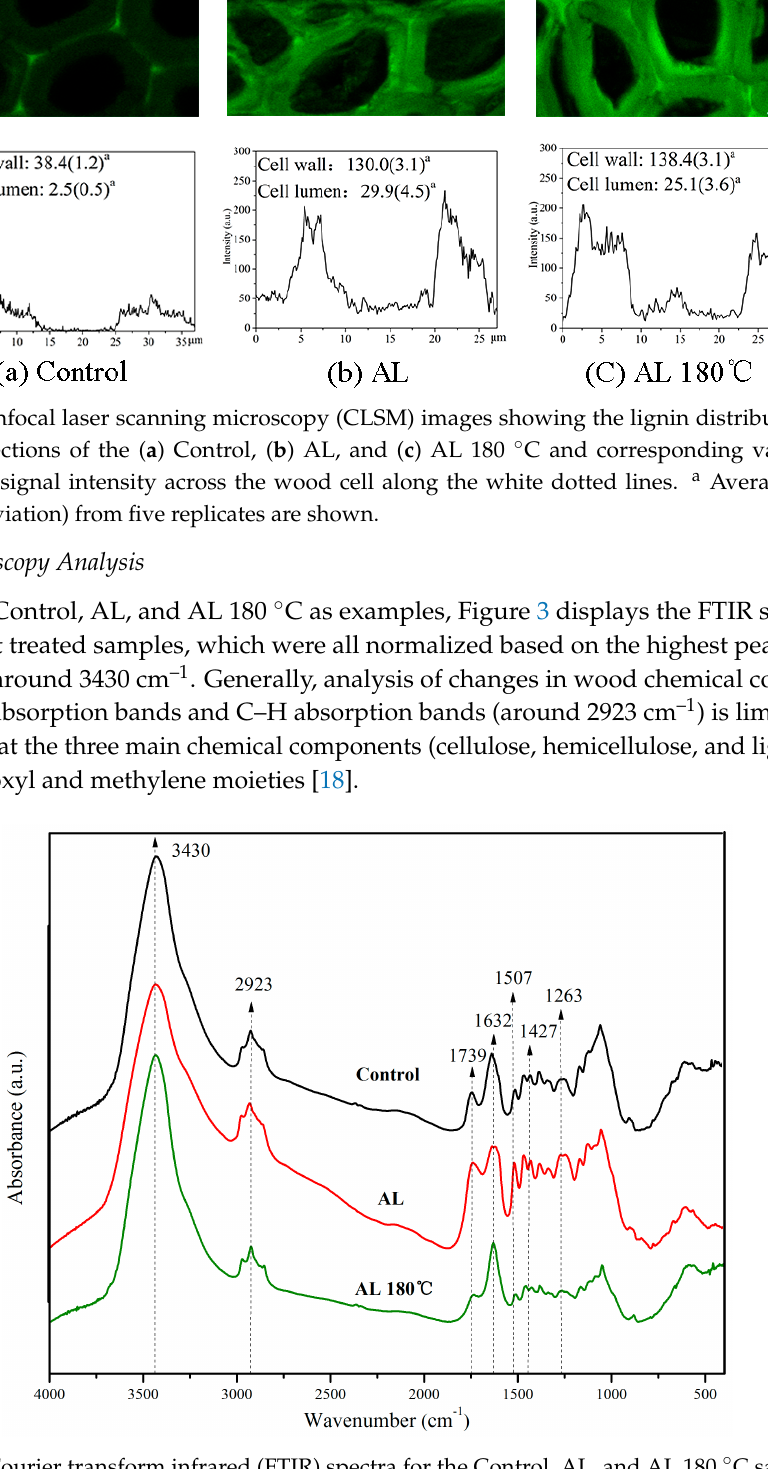
Figure 3. Fourier transform infrared (FTIR) spectra for the Control, AL, and AL 180 °C samples.